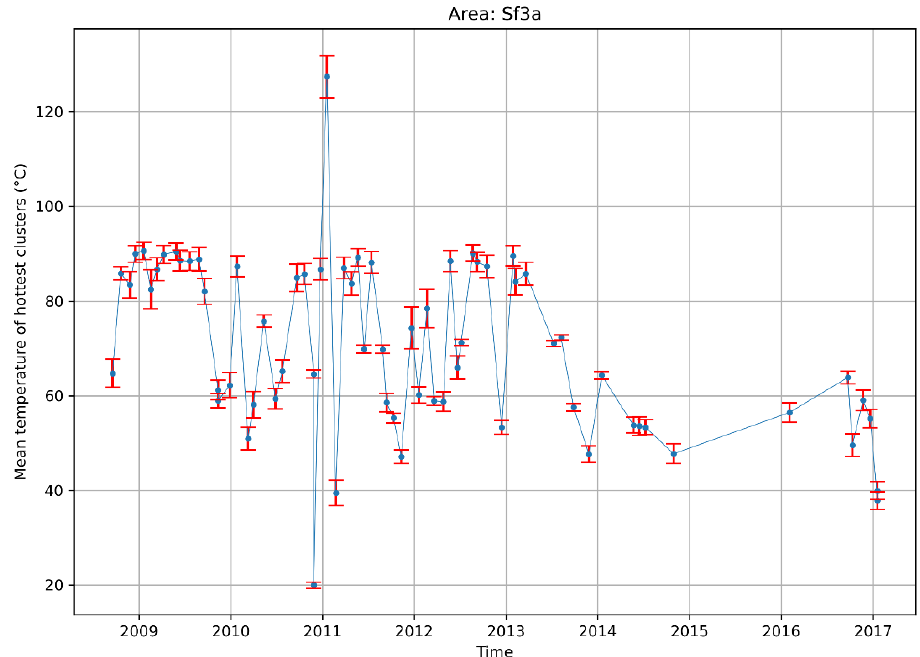
Figure 10. Thermal image example taken in La Solfatara crater (Campi Flegrei), indicated as “Sf3a” in Figure 1.